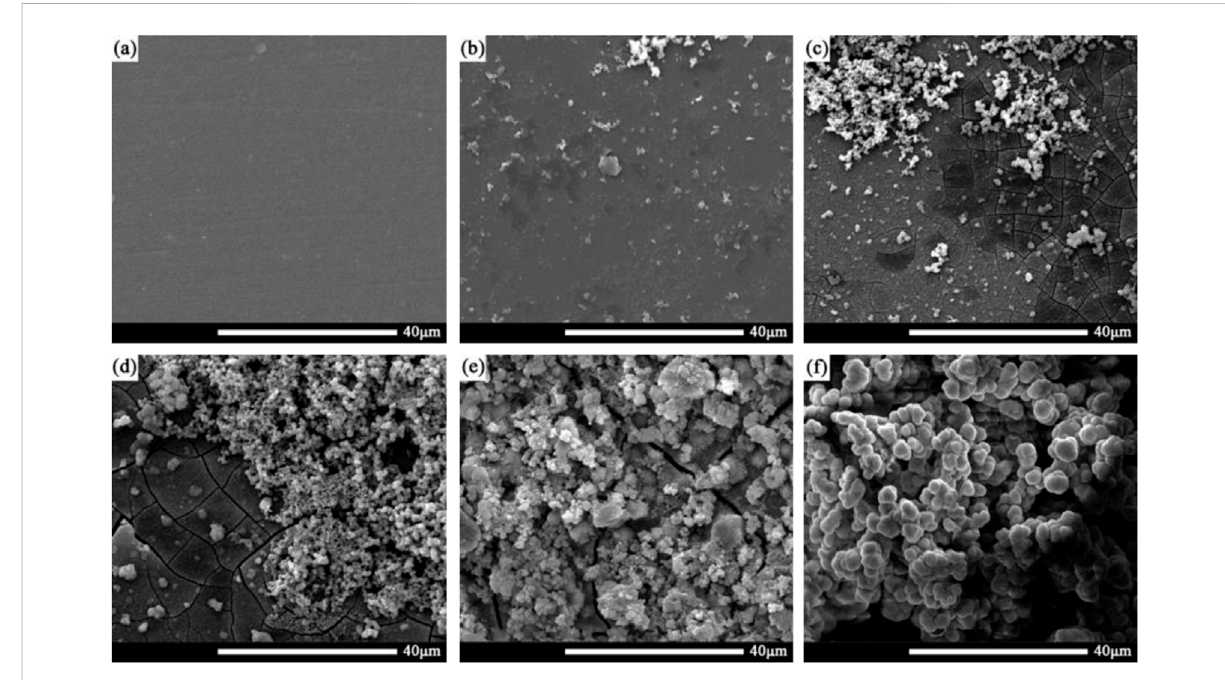
FIGURE 6 Corrosion product of 2060-T6 Al-Li alloy samples with different immersion time, (A) 0 h, (B) 6 h, (C) 24 h, (D) 72 h, (E) 168 h, (F) 720